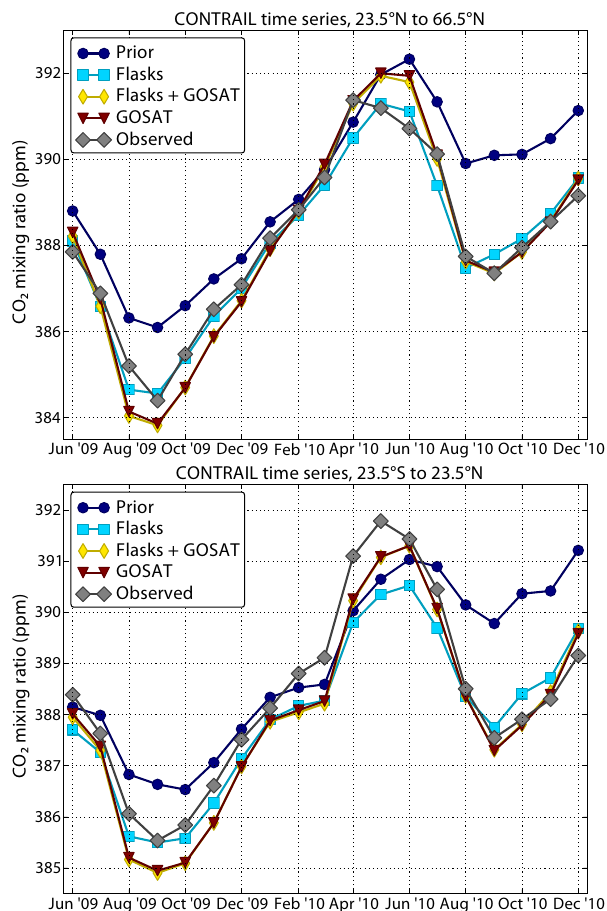
Fig. 5. Monthly averaged CONTRAIL data between (top) 23.5 ◦ N and 66.5 ◦ N and (bottom) 23.5 ◦ S and 23.5 ◦ N, along with posterior CO 2 fields sampled at CONTRAIL sample